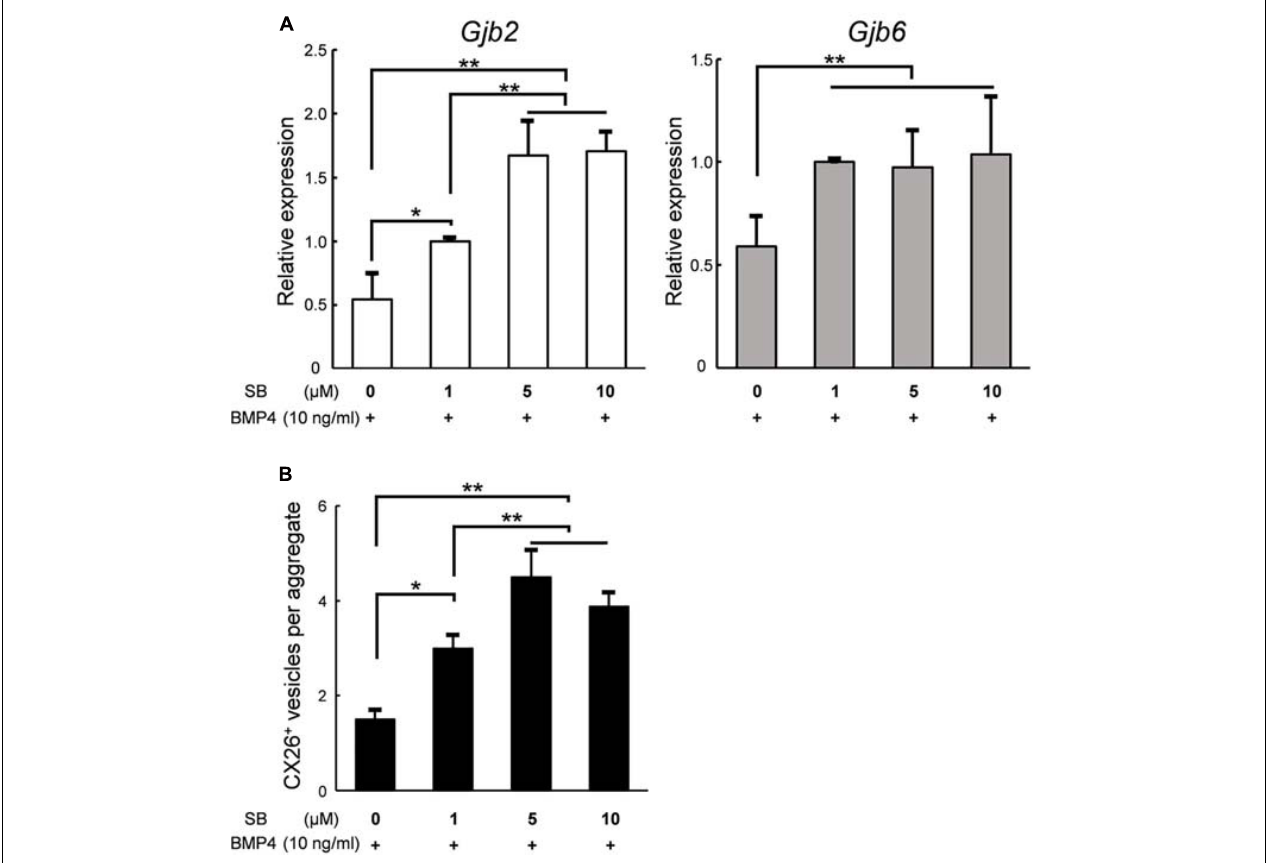
FIGURE 6 | In SFEBq cultures, SB had a dose-dependent effect on Gjb2 / Gjb6 mRNA expression and the number of CX26 + vesicles. (A) Relative expression of Gjb2 and Gjb6 mRNA in day 7 aggregates from SFEBq cultures after treatment with BMP4 (10 ng/ml) alone or with SB (1–10 µ M) as indicated. mRNA expression was normalized to that of cultures treated with BMP4/1 µ M SB. The data are expressed as the mean ± SE from five independently generated cell cultures per treatment; for each replicate, expression was assessed in eight aggregates per treatment. (B) The average number of CX26 + vesicles per aggregate from aggregates treated as described in (A) . The data are expressed as the mean ± SE from three independently generated cell cultures per treatment; for each replicate, vesicles were quantified for 2–3 aggregates per treatment ( n = 8 aggregates in total). Statistical differences among samples were assessed by a one-way ANOVA and Scheffe’s multiple comparison test; * p < 0.05; ** p <